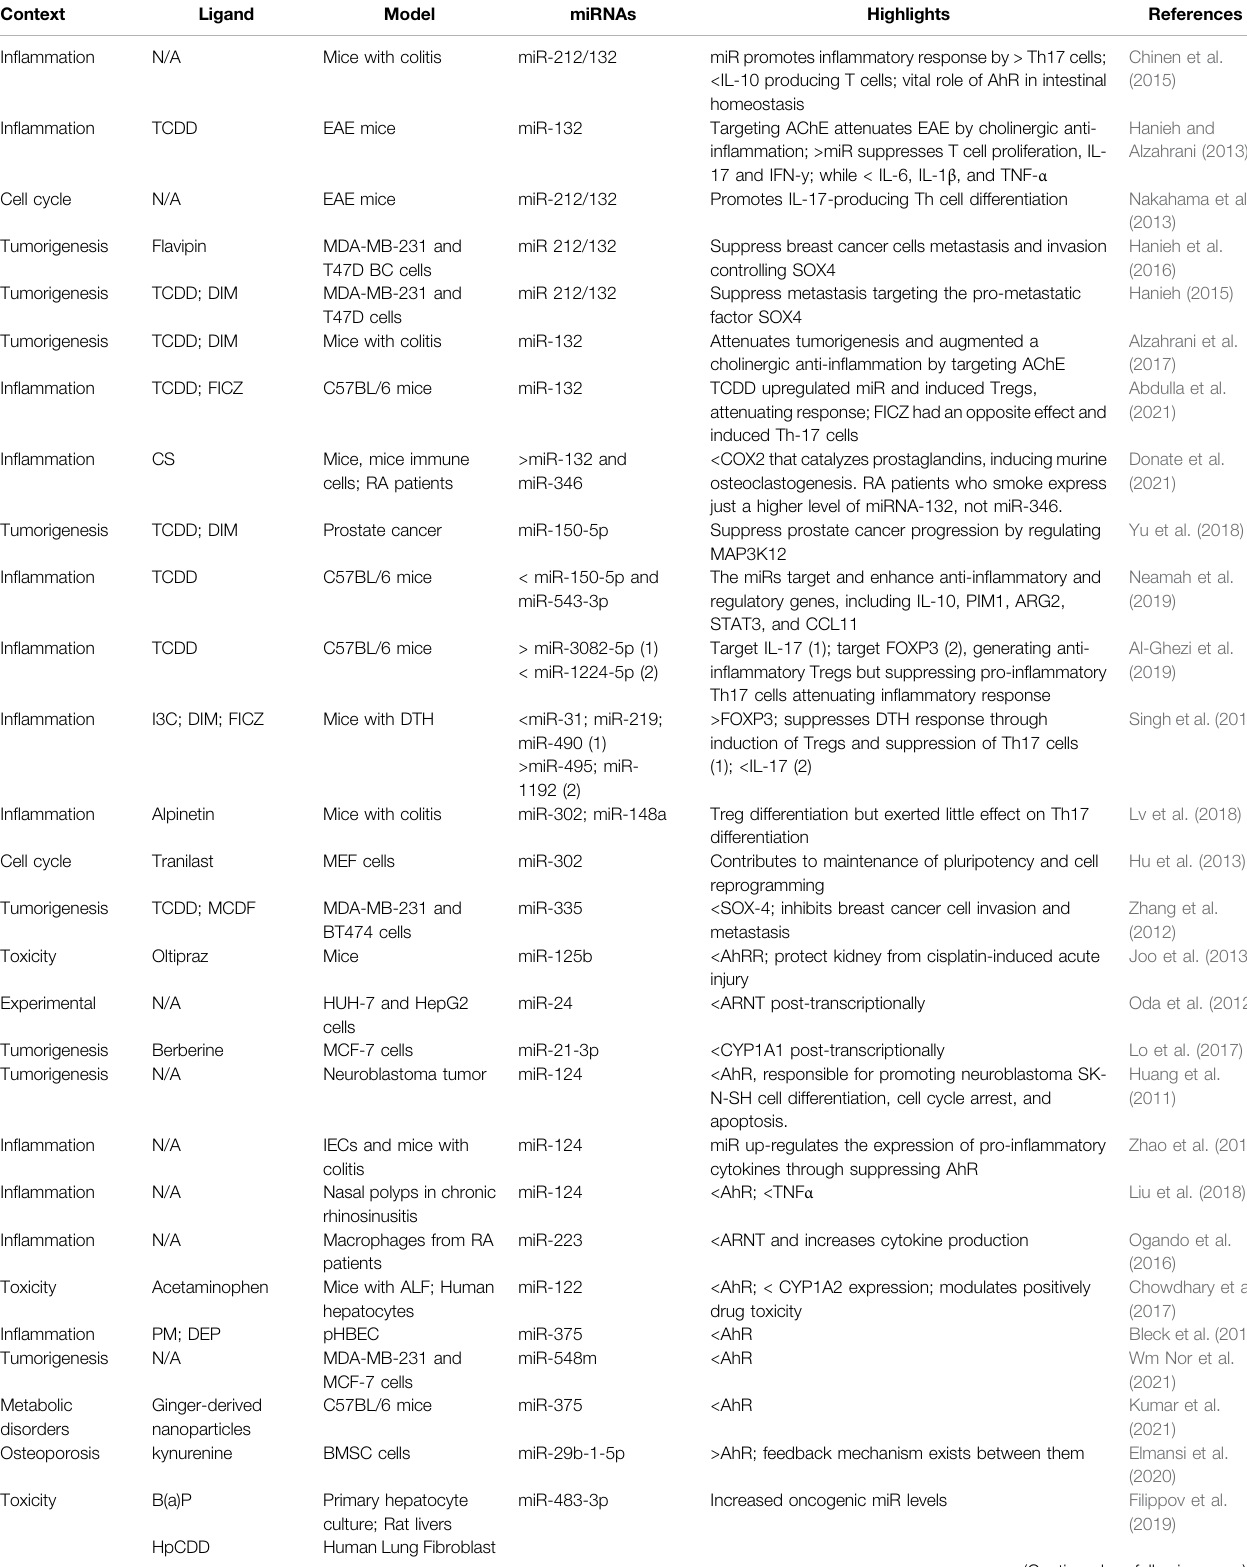
TABLE 1 | Summary of the reviewed papers examining AhR-miRNA axis mutual regulation